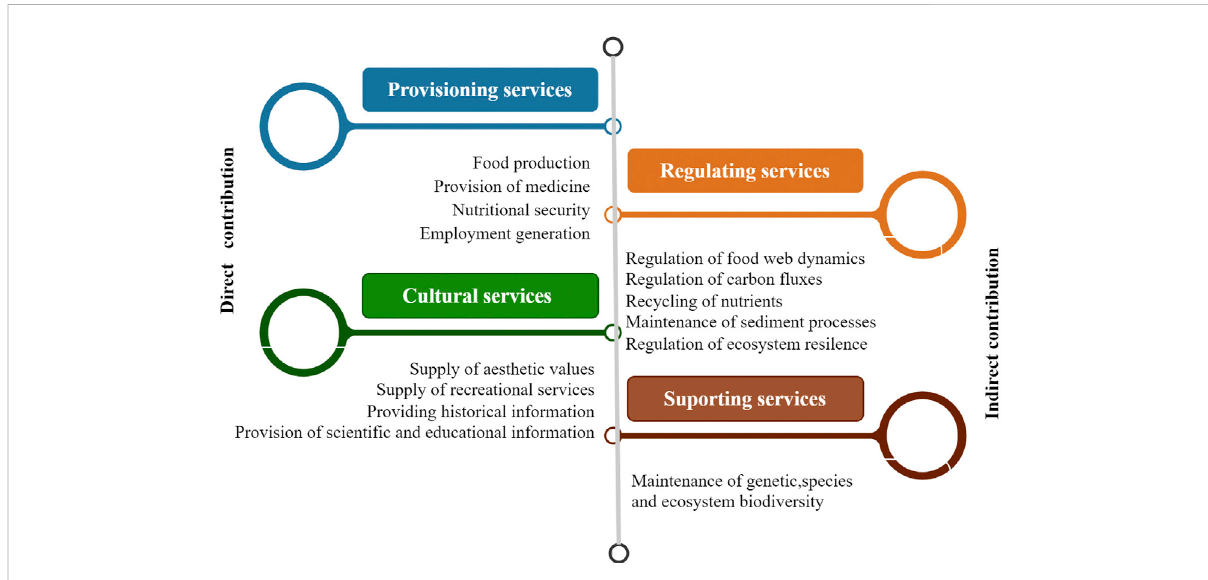
FIGURE 1 An overview of ecosystem services generated by riverine fi sheries. Adapted from (Holmlund and Hammer,